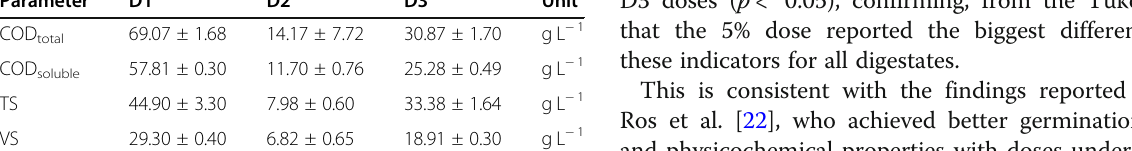
Table 2 Stability parameters for the digestates assessed